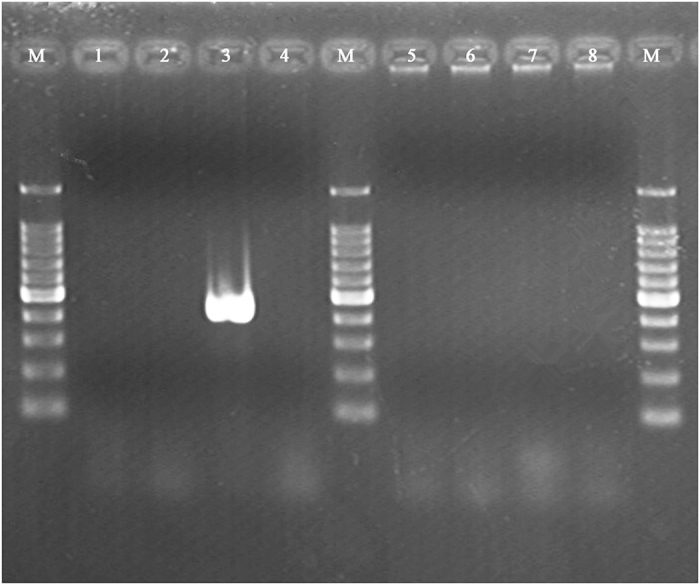
PCR product agarose gel electrophoresis for the identification of S. aureus ATCC25923 agr genotype.Whole- cell PCR was performed with each of the four agr specificity primers. Lines 1 to 4, PCR product using the same forward primer pan-agr and different reverse primers (agrI, agrII, agrIII, and agrIV) with S. aureus ATCC25923 genomic DNA as templates (439 bp for agrI, 573 bp for agrII, 406 bp for agrIII, and 657 bp for agrIV); Lines 5 to 8, negative controls responsible to lines 1 to 4, respectively; Lines M, 100 bp for DNA ladder.